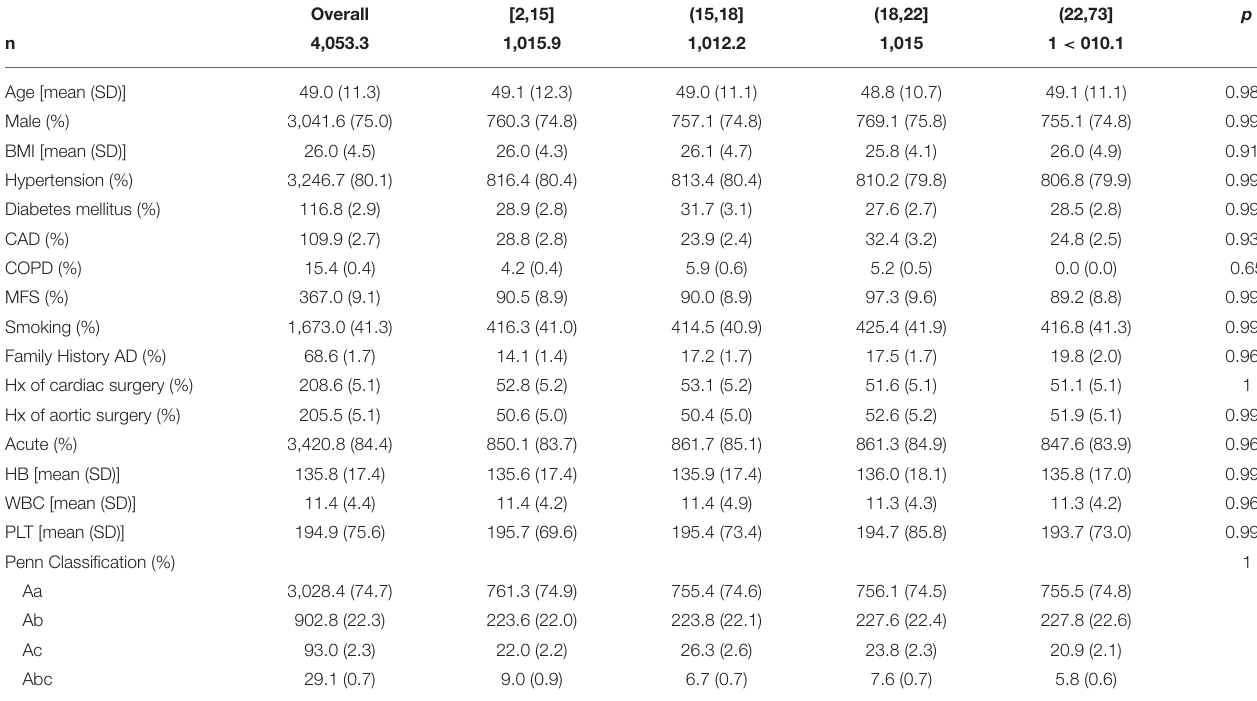
TABLE 1 | Preoperative characteristics after propensity score matching.